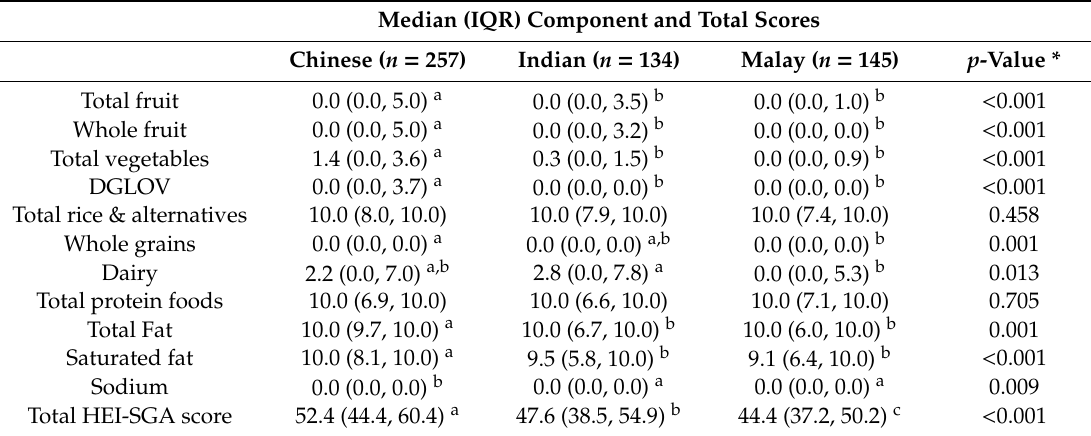
Table 4. Median component and total HEI-SGA values across all participants by ethnicity. Median (IQR) Component and Total Scores Chinese ( n = 257) Indian ( n = 134) Malay ( n = 145) p -Value